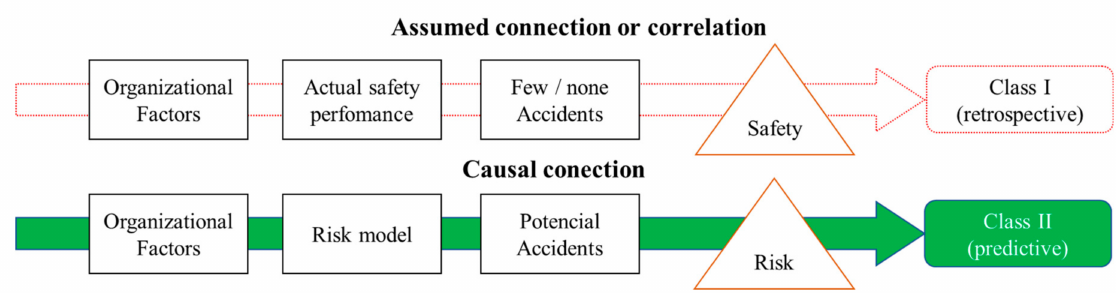
Figure 1. Proactive approaches to assess organizational factors’ effect on safety/risk (Adapted from [5,20]).